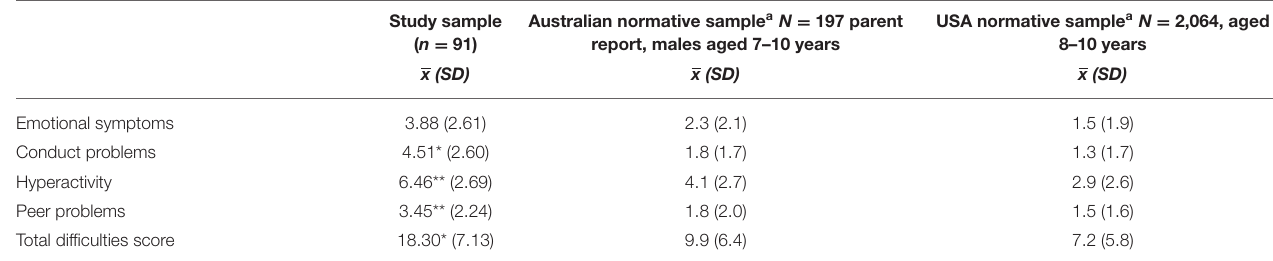
TABLE 2 | Baseline SDQ mean scores ( n =